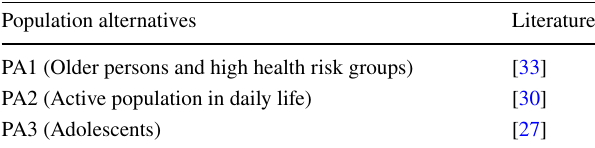
Table 10 Population-based strategic priorities for vaccination policy in the COVID-19 period Population